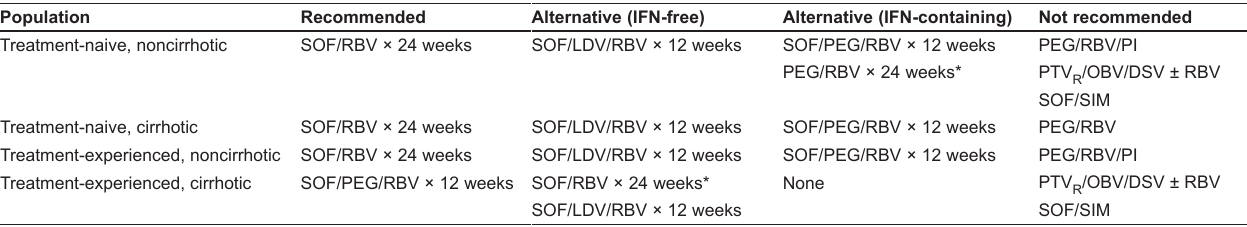
TABle 7 Patients with hepatitis C virus genotype 3